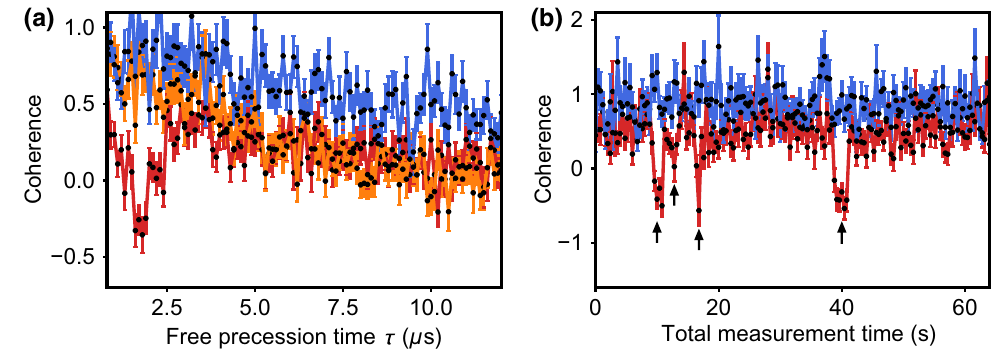
FIG. 4. Transient strong coupling of surface spins. (a) Coherence (blue), coherently coupled DEER signal (red), and incoherent bath signal (orange) from the same NV center measured at different times. (b) Time series for the NV center in (a), with a fixed free precession interval of 2 μ s. The DEER signal drops below 0 for short intervals, indicating transient coherent coupling to a nearby dark spin (black arrows). Error bars are the standard error of the mean due to photon shot